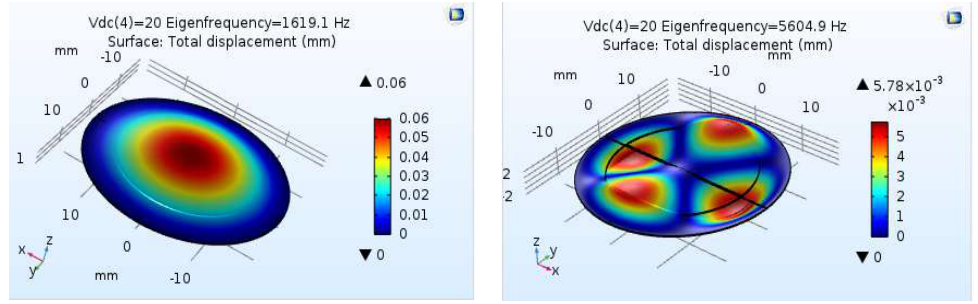
Figure 4. First and fourth modes of eigenfrequency analysis for piezoelectric PZT 5H diaphragm.